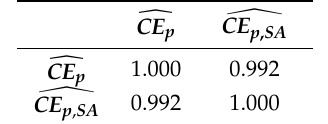
Note: SA denotes seasonally adjusted